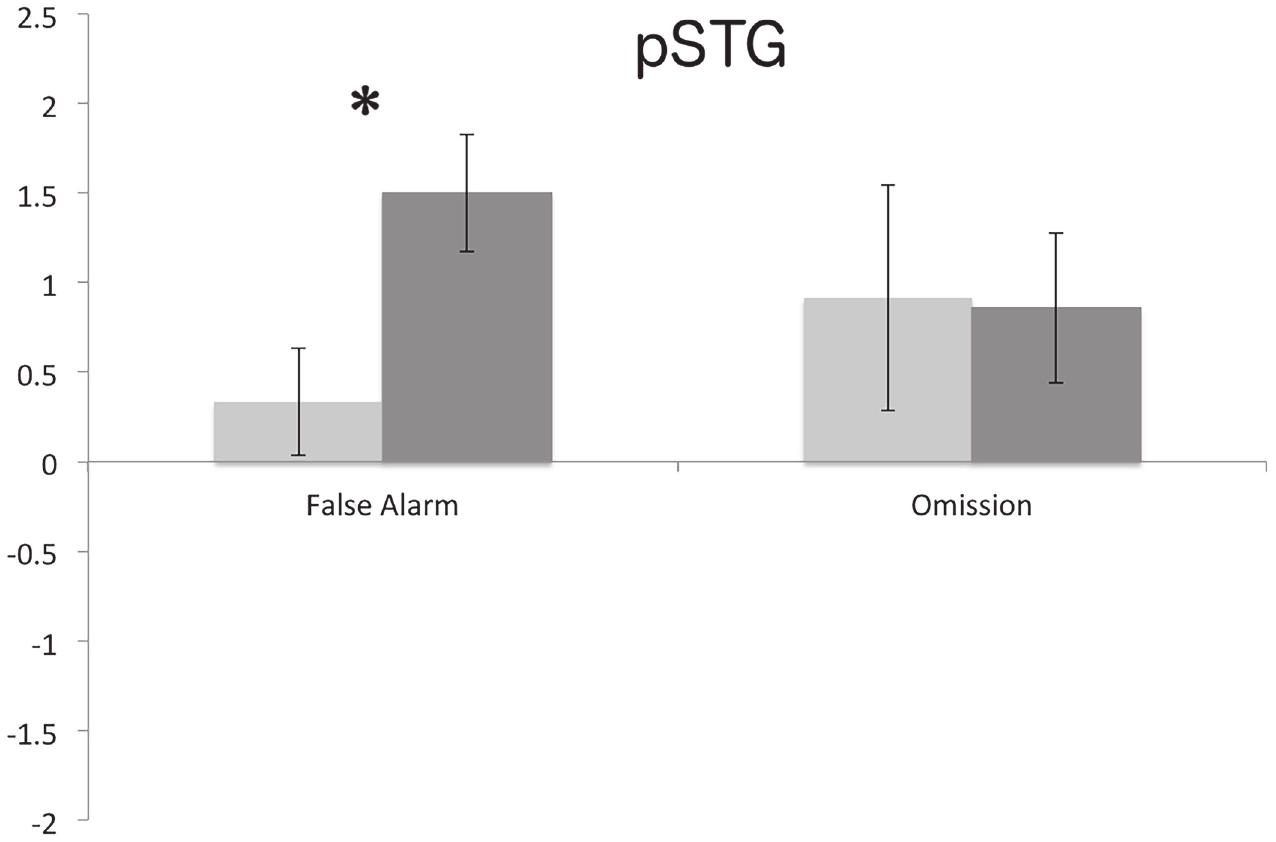
Fig 5. Normalized false alarm and omission errors (group mean +/- SE) for IFG and pSTG stimulation.